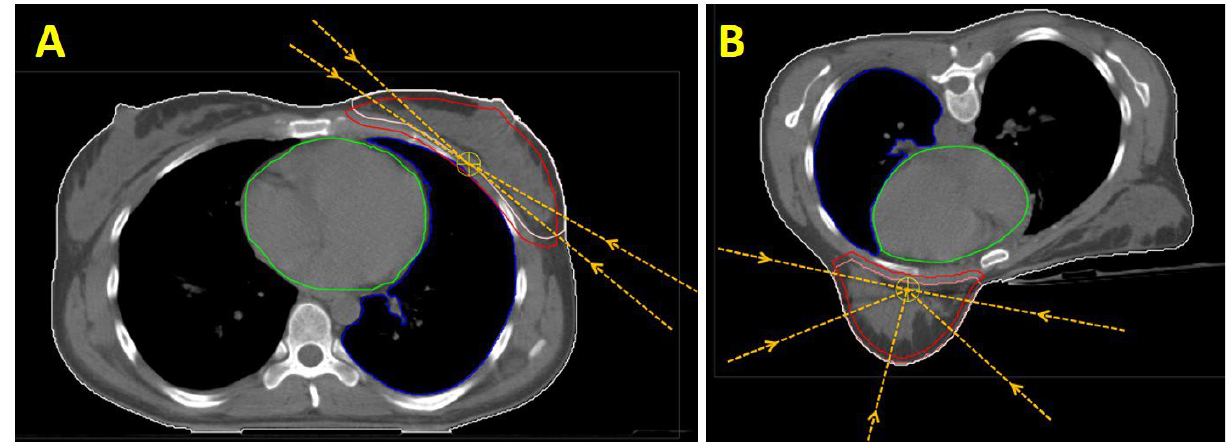
Figure 1. ( A ): Illustration of the main EBRT directions for the IMRT technique for treating the breast (PTV “B”) in the supine position (“tangential IMRT”). Also shown is the contour of the CTV “Breast” (light red) and PTV “B” (red), as well as the OARs “heart” (green) and ipsilateral lung (blue). ( B ): Main EBRT directions for the IMRT technique for treating the breast in a laterally tilted prone position (“multibeam IMRT”).